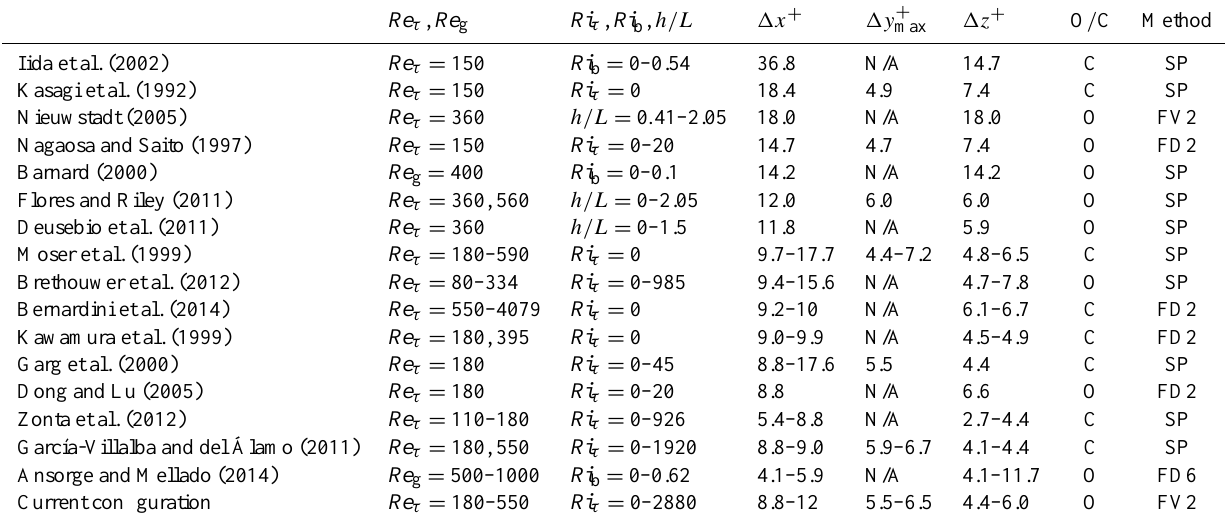
Table 2. Summary of different grid resolutions used for DNS studies of neutral and stratified channel flows. Re τ is friction Reynolds number; Re g is Reynolds number based on geostrophic wind; Ri τ is friction Richardson number; Ri b is bulk Richardson number; h/L is stability parameter; x,y,z are streamwise, vertical, and spanwise directions, respectively; (cid:49)x + ,(cid:49)y + ,(cid:49)z + are the normalized grid resolution (e.g., (cid:49)x + = (cid:49)xu τ /ν ); O and C denote the open-channel and closed-channel flows, respectively; and FD, FV, and SP represent finite-difference, finite-volume, and spectral methods, respectively. The numbers in the FD and FV methods represent the order of accuracy for the adopted spatial discretization